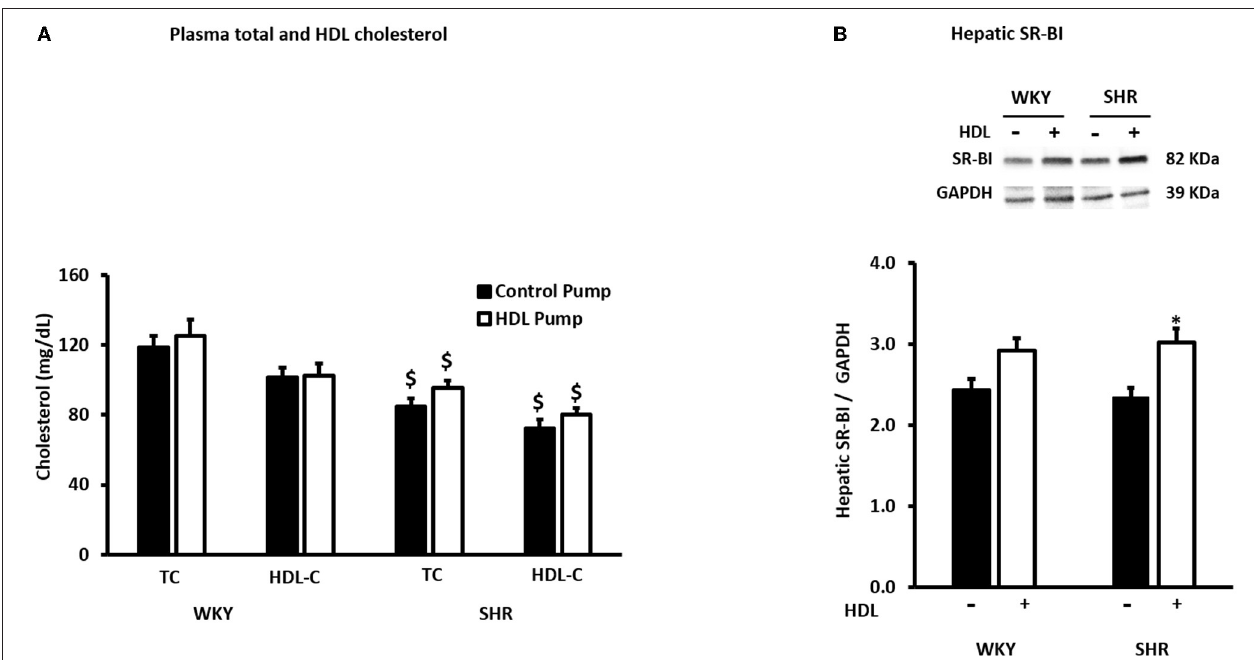
FIGURE 2 | Effects of HDL treatment on plasma cholesterol and hepatic SR-BI expression in WKY and SHR. Plasma total and HDL cholesterol levels (A) and hepatic SR-BI expression (B) in WKY and SHR treated with or without HDL. Data are mean ± SEM, $ P < 0.05 vs. the same parameter and treatment group in WKY, n = 7–10, * P < 0.05 vs. untreated animals of the same genotype, n =